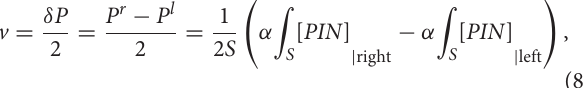
P r c n P l c n 1 , n n 1 ≃ + + +